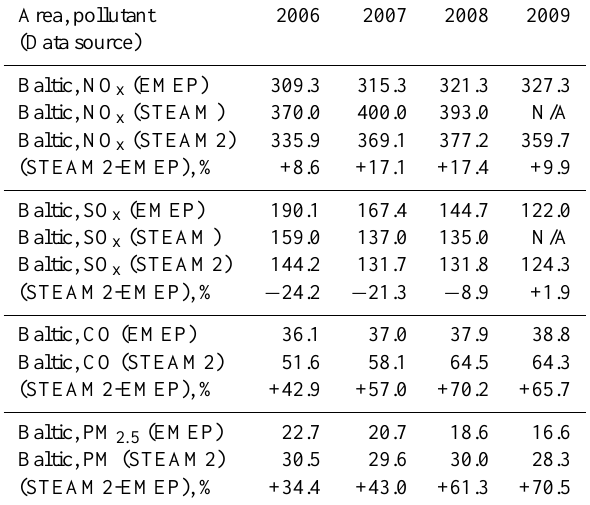
Table 2. Emissions from ships in the Baltic Sea during 2006–2009 according to various studies. Data from EMEP was extracted from (www.ceip.at). All values in the table are presented in units of Gg. The percentage differences of the predictions of STEAM2 com- pared with those of EMEP are also presented. N/A=not